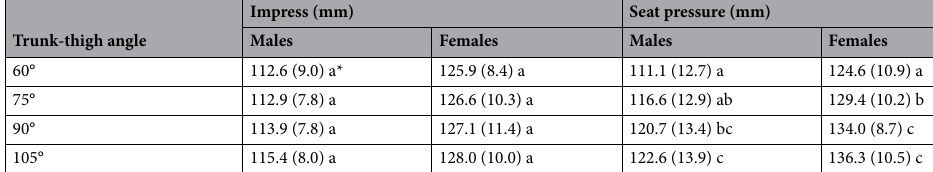
Table 4. Duncan’s multiple range test results on external ischial tuberosity width for one-way ANOVA. * Data (mean, with standard deviation in parentheses) with the same lowercase letter do not differ in the Duncan test.